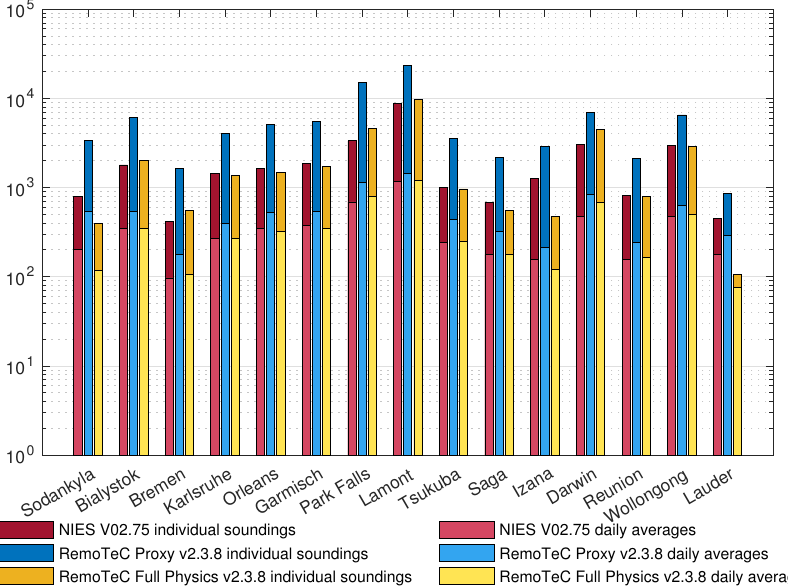
Figure 5. Number of individual soundings and daily averages for three GOSAT XCH 4 retrievals studied at 15 different TCCON sites. The sites are organized based on their